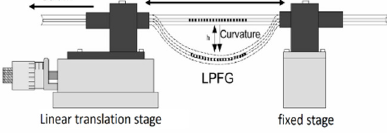
Fig. 1. Curvature and strain measurement